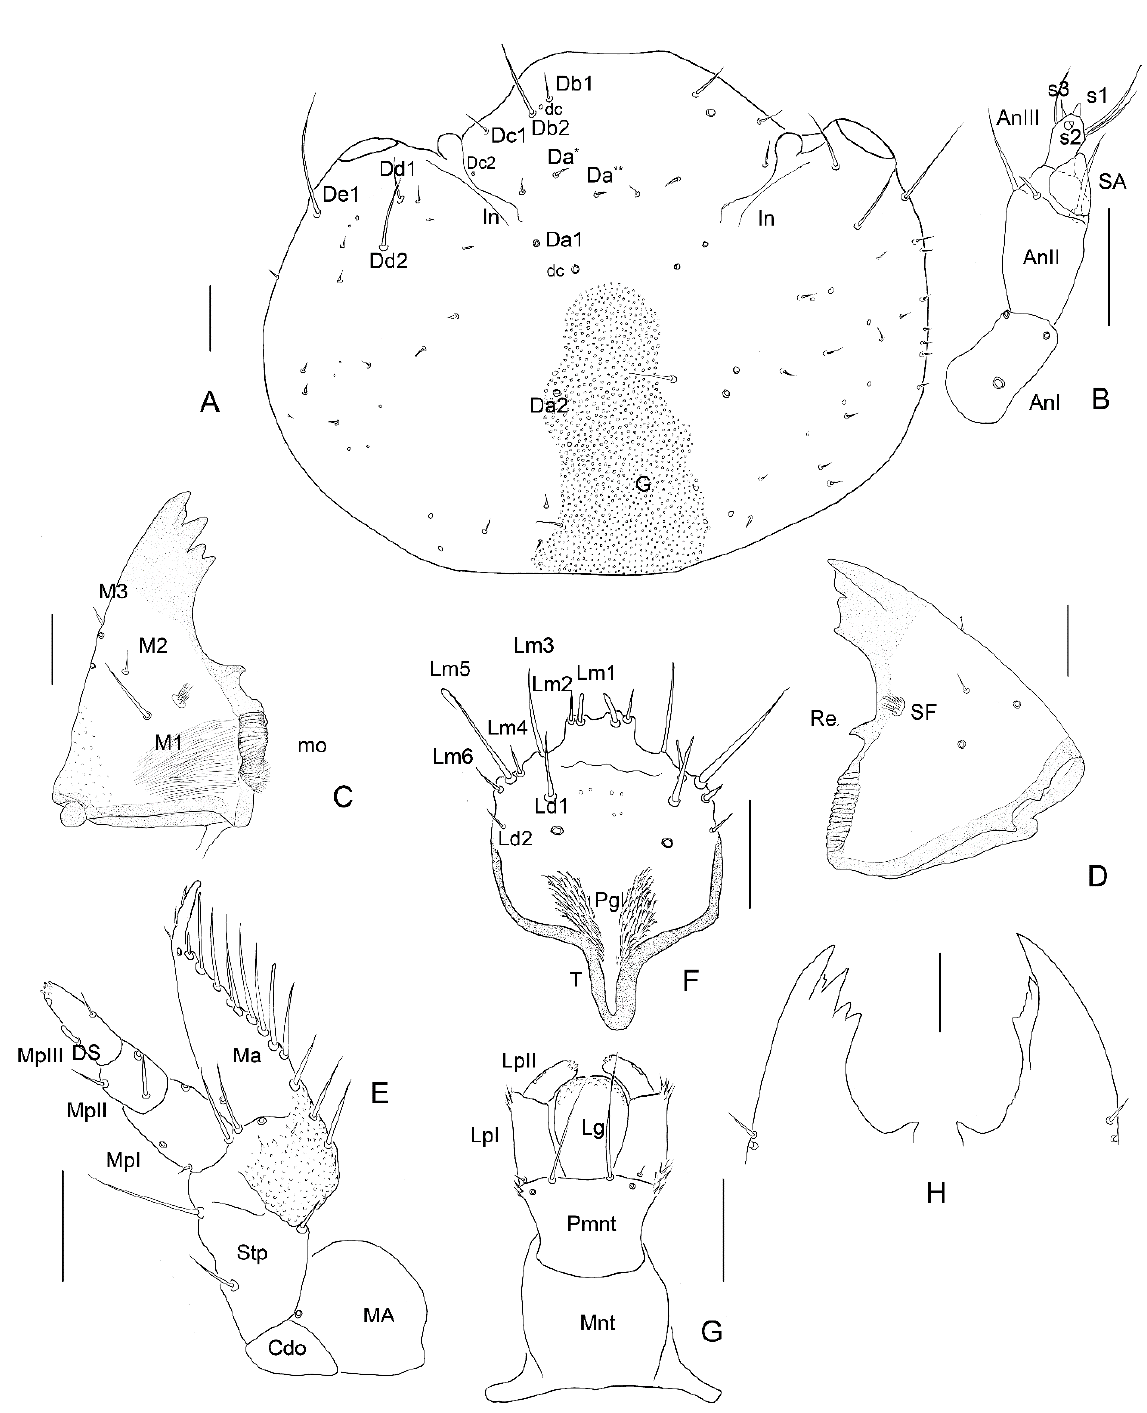
Figure 4. Leiodes cinnamomea . Details of larval morphology of instar I. ( A ) Dorsal side of head. ( B ) Antenna. ( C ) Left mandible, ventral view. ( D ) Right mandible, ventral view. ( E ) Maxilla, ventral view. ( F ) Labrum, ventral view. ( G ) Labium, ventral view. ( H ) Apices of mandibles. Abbreviations: AnI, AnII, AnIII—antennomere I, II, III; SA—sensory appendage: Cdo—cardo; DS—digitiform sensillum; G—granulation; In—invagination; LpI, Lp II—labial palpi segment I, II; Lg—ligula; MA—maxillary area; Ma—mala; Mnt—mentum; Mo—mola; MpI, MpII, MpIII—maxillary palpi segment I, II, III; P—pocket; Pgl—paraglossae; Pmnt—prementum; Re—retinaculum; SF—setal field; Stp—stipes. The other abbreviations refer to the terminology of setae. Scale bars = 0.1 mm.